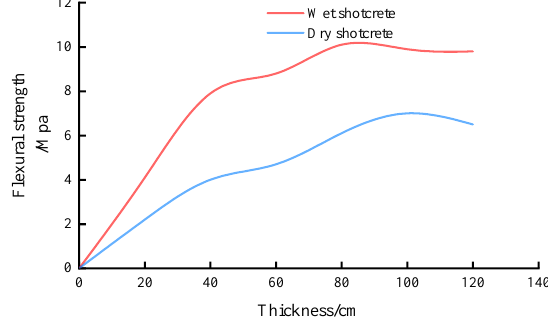
Figure 11. Relationship curve of flexural strength and thickness.